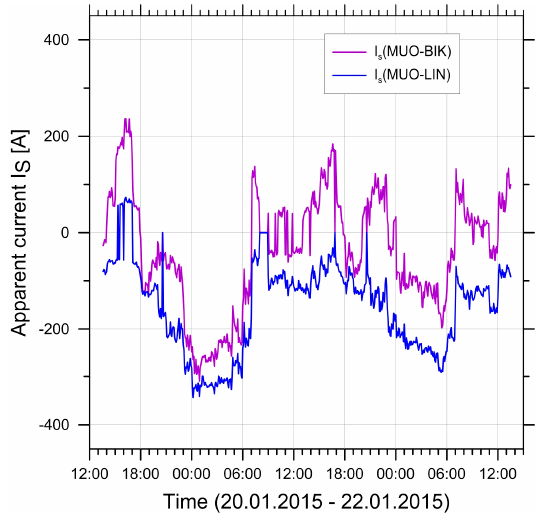
Figure 2. Daily variation of current data in two circuits of a 220 kV/220 kV line. Data from the first measurement period. The colours distinguish the two circuits. MUO ‐ BIK, Mühleberg ‐ Ost to Bickigen; MUO ‐ LIN, Mühleberg ‐ Ost to Lindenholz.